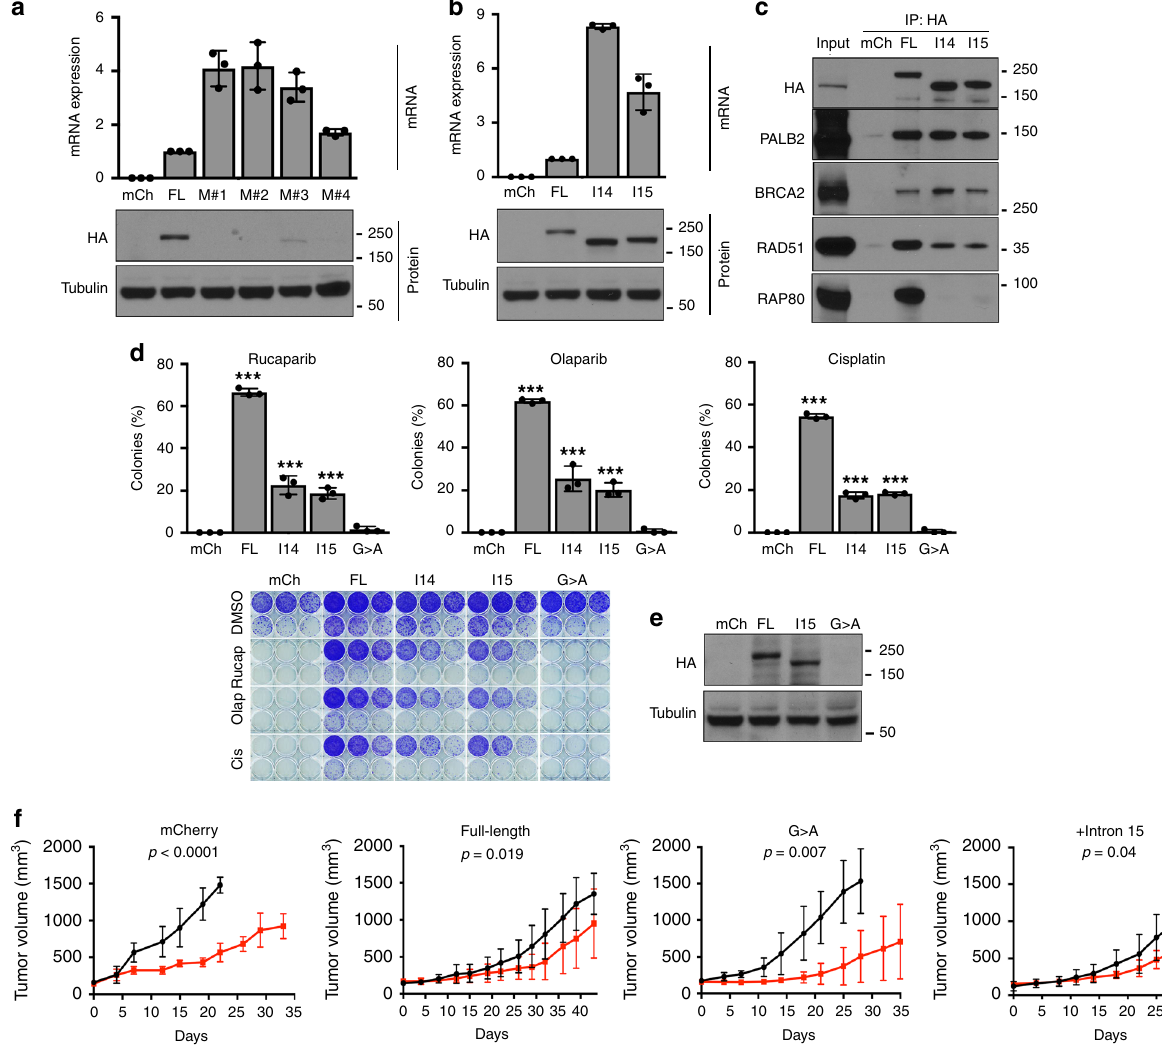
Fig. 5 BRCA1-I15 is stable and hypomorphic. a MDA-MB-436 cells engineered to express mCherry (mCh), HA-BRCA1 full-length/wild-type (FL), or the HA-BRCA1 BRCT mutations (M) c.5251 C > T-(M#1), c.5263insC-(M#2), c.5277insTA-(M#3), c.5445 G > A-(M#4), that are endogenously present in HCC1395, HCC1937, MDA-MB-436 and SNU-251 BRCA1 BRCT mutant cell lines, respectively; and were assessed for HA mRNA by qRT-PCR. HA expression normalized to FL expressing cells is shown (above). HA protein expression was assessed from the same cells by Western blotting (below). b MDA-MB-436 cells engineered to express mCh, BRCA1-FL, BRCA1-I14-(I14), and BRCA1-I15-(I15) were assessed as described in a . See Supplementary Fig. 4b. c Cells from panel b were subject to HA-immunoprecipitation with the indicated antibodies. d mCh, BRCA1-FL, BRCA1 – 14, BRCA1-I15, and BRCA1 c.5445 G > A (SNU-251 mutation) expressing MDA-MB-436 cells were seeded at decreasing densities in the presence of 20 nM rucaparib, 20 nM olaparib or 20 ng/ml cisplatin and assessed for colony formation. *** p < 0.001 compared to mCh cells. Below, representative plates. For panels a − d , data are the mean ± SD of n = 3 biological replicates. Statistical signi fi cance was assessed by unpaired, two-tailed t tests. e mCh, BRCA1-FL, BRCA1-I15, and BRCA1 c.5445 G > A expressing MDA-MB-436 tumor xenografts were harvested and assessed for HA expression by Western blotting. f Mice harboring mCh, BRCA1-FL, BRCA1-I15, and BRCA1 c.5445 G > A expressing MDA-MB-436 tumor xenografts were treated with vehicle (black line) or 200 mg/kg rucaparib bi-daily (red line) for 2 × 5 days with a 2-day interval. Mean ± SD. Tumor volumes are shown for fi ve tumors implanted in fi ve separate mice per cell line per treatment from the same experiment. A linear mixed effects model tested the difference in slopes of log- tumor volume, and p values shown are tests of differences in growth rates between vehicle and rucaparib-treated tumors. Moreover, differences-in-slopes (i.e. vehicle to PARPi differences) were compared using Tukey ’ s correction for multiple comparisons: BRCA1 5445 G > A vs. BRCA1-I15 ( p = 0.02), BRCA1 5445 G > A vs. BRCA1-FL ( p < 0.001), BRCA1-I15 vs. mCh ( p = 0.04), and mCh vs. BRCA1-FL ( p = 0.001), 5445 G > A vs. mCh ( p = 0.99) or BRCA1-I15 vs. BRCA1-FL ( p = 0.57). See Supplementary Data 1 fi le for more details. PARPi/chemo-resistance, and could serve as a predictive biomarker presence of 1µM rucaparib until a resistant population emerged (SNU-251-RR). Cells were cultured in the absence of rucaparib for a minimum of 2 weeks before of clinical response in patients with BRCA1 BRCT mutant cancers. they were used for experiments. Cell lines tested negative for mycoplasma and identities were con fi rmed using short-tandem repeat (STR) pro fi ling by IDEXX Methods Bioresearch. Chemicals were purchased from Sigma-Aldrich unless stated other- wise. Clovis Oncology provided rucaparib. Olaparib and niraparib were purchased Cell lines and reagents . SNU-251 cells were obtained from the Korean Cell line from Selleckchem. Cisplatin was from APP/Fresenius Kabai USA LLC. bank. All other cell lines were from ATCC. SNU-251 cells were cultured in the